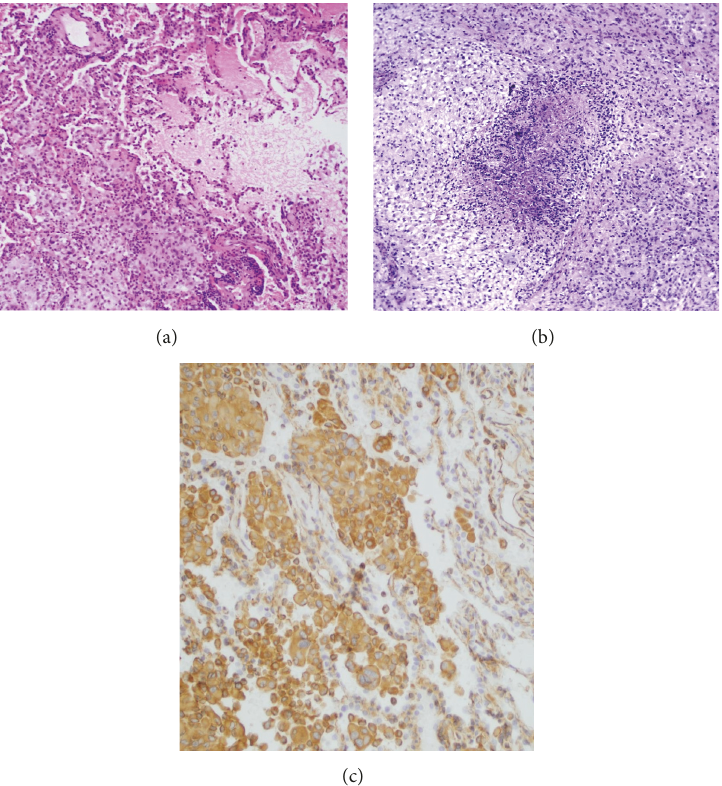
Figure 3: Lung tumor. (a) The tumor forms a solid mass (left side) with bordering alveoli (right side) (H&E, 100x). (b) Necrosis in the lung tumor (H&E, 100x). (c) GFAP immunostain demonstrating immunopositive tumor cells in the lung with immunonegative pulmonary cells (right side) (GFAP immunostain,